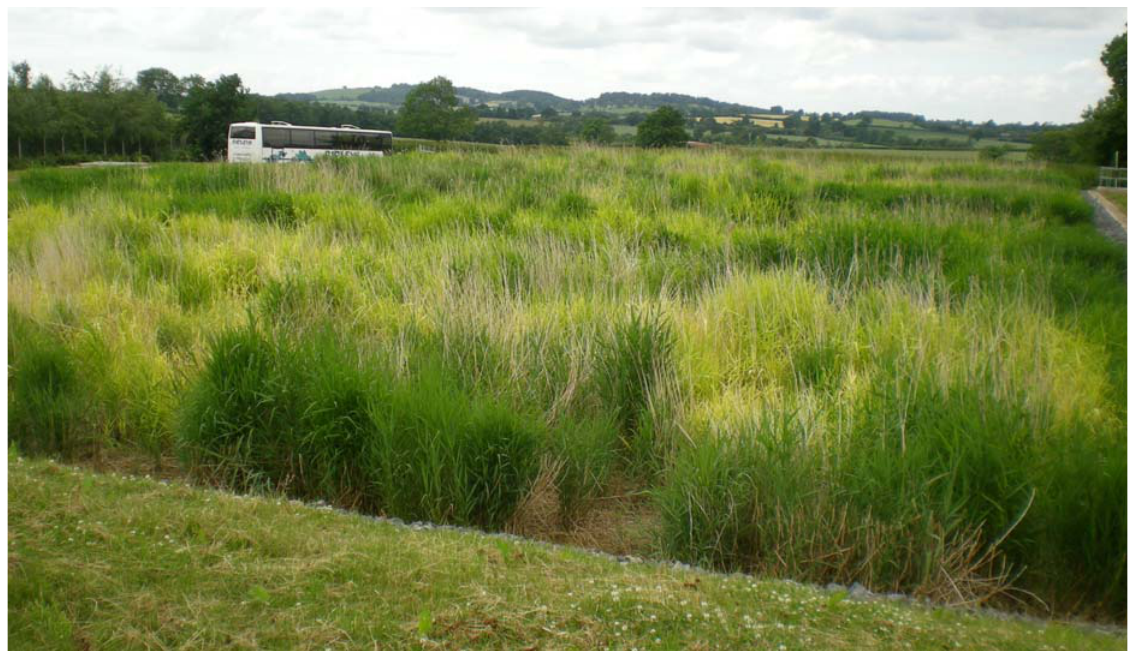
Figure 7. HF CWs at Staverton, United Kingdom. Tertiary treatment for 603 PE. Photograph taken by the author.